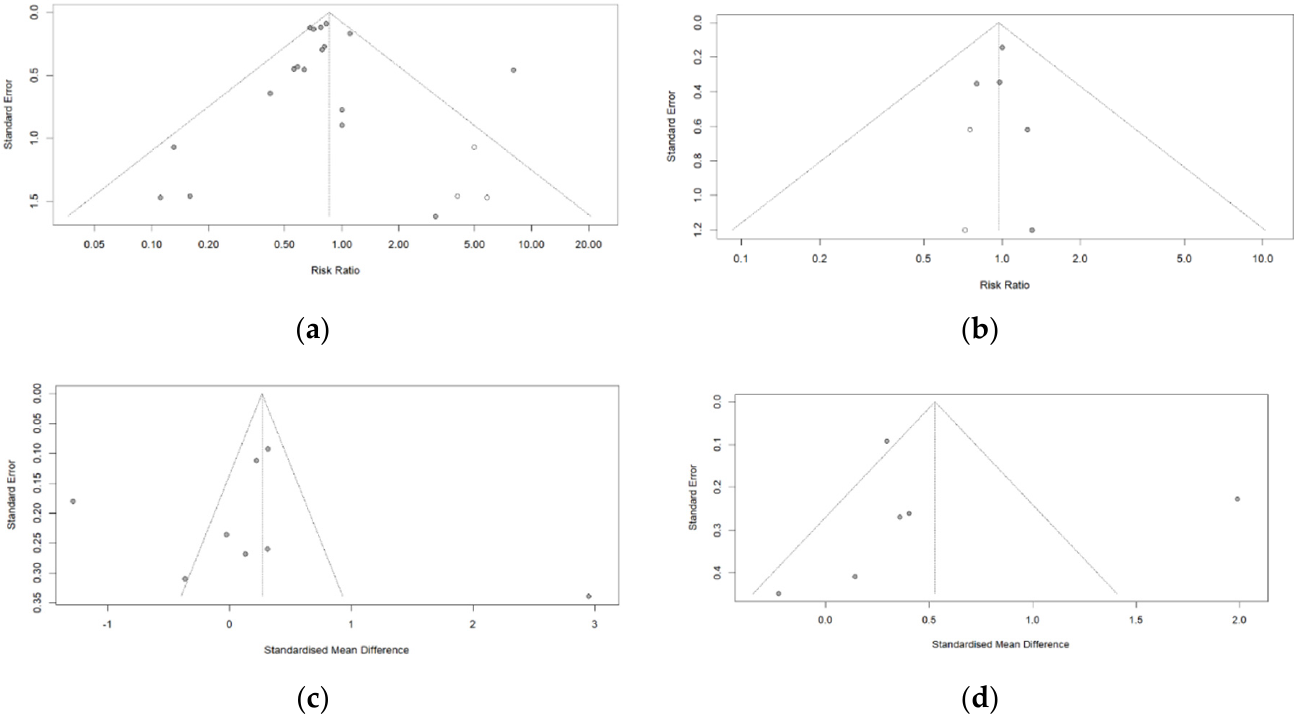
Figure 5. Funnel plots for publication bias evaluation. ( a ) All-cause mortality, ( b ) ventilation incidence, ( c ) hospitalization duration, and ( d ) length of ICU stay between intervention and control groups. Table 4. Trimmed effect size of vitamin C administration in COVID-19 Table 3. Egger’s linear regression test for publication bias.